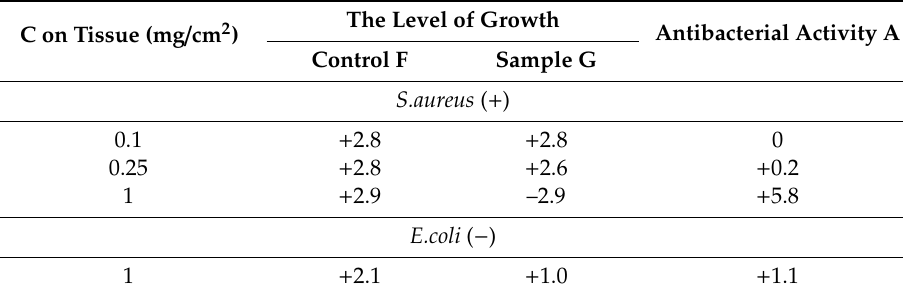
Table 5. Antibacterial activity of dark titania towards S. aureus and E. coli